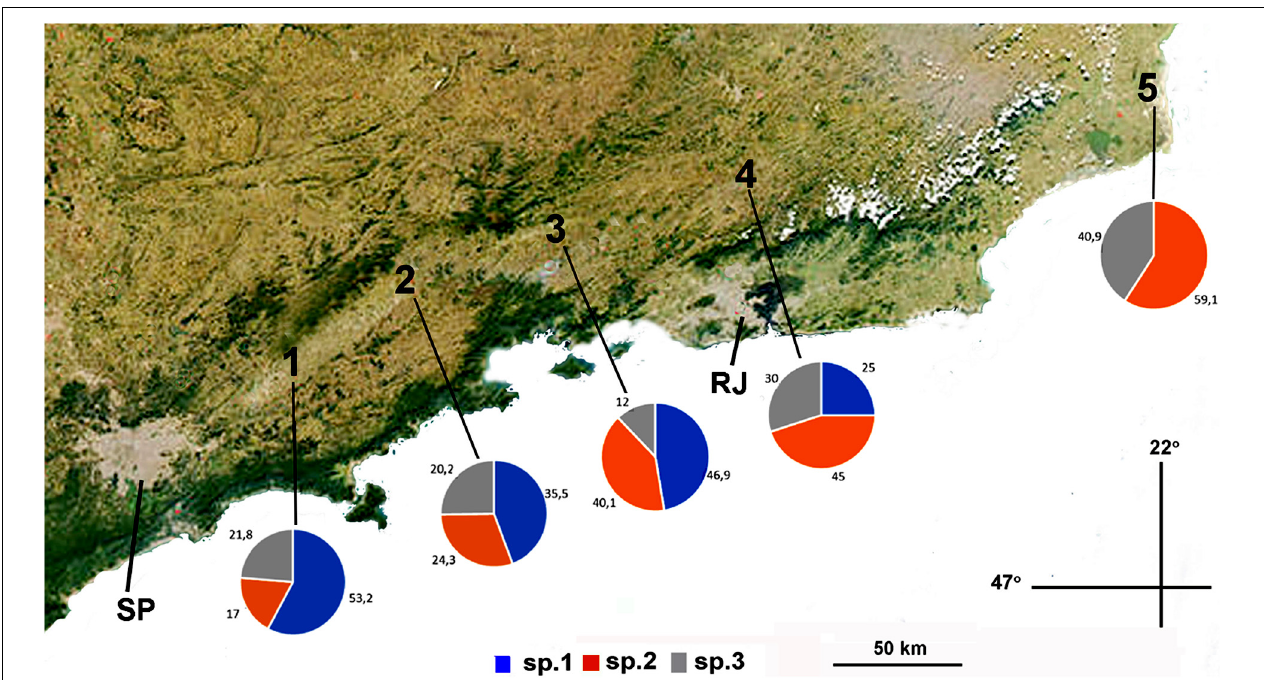
FIGURE 2 | Frequencies of A . sp.1, A. sp.2, and A . sp.3 along the valley of Paraíba do Sul River. Identification of the species was determined by the chromosomic analysis. (1) Areas of Santa Isabel (800 m); (2) Lorena (550 m); (3) Resende (450 m); (4) Três Rios (280 m), and (5) Campos dos Goitacazes (sea level). SP, RJ, cities of São Paulo and Rio de